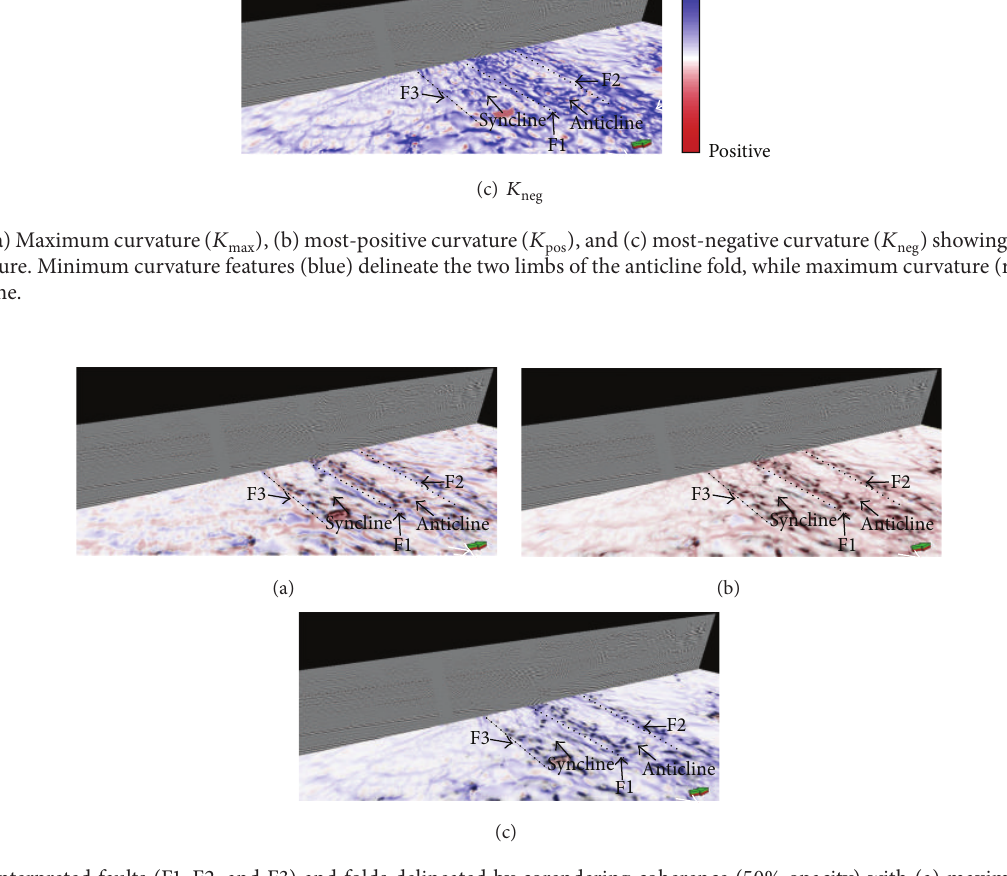
) , and (c) most-negative curvature (𝐾 pos